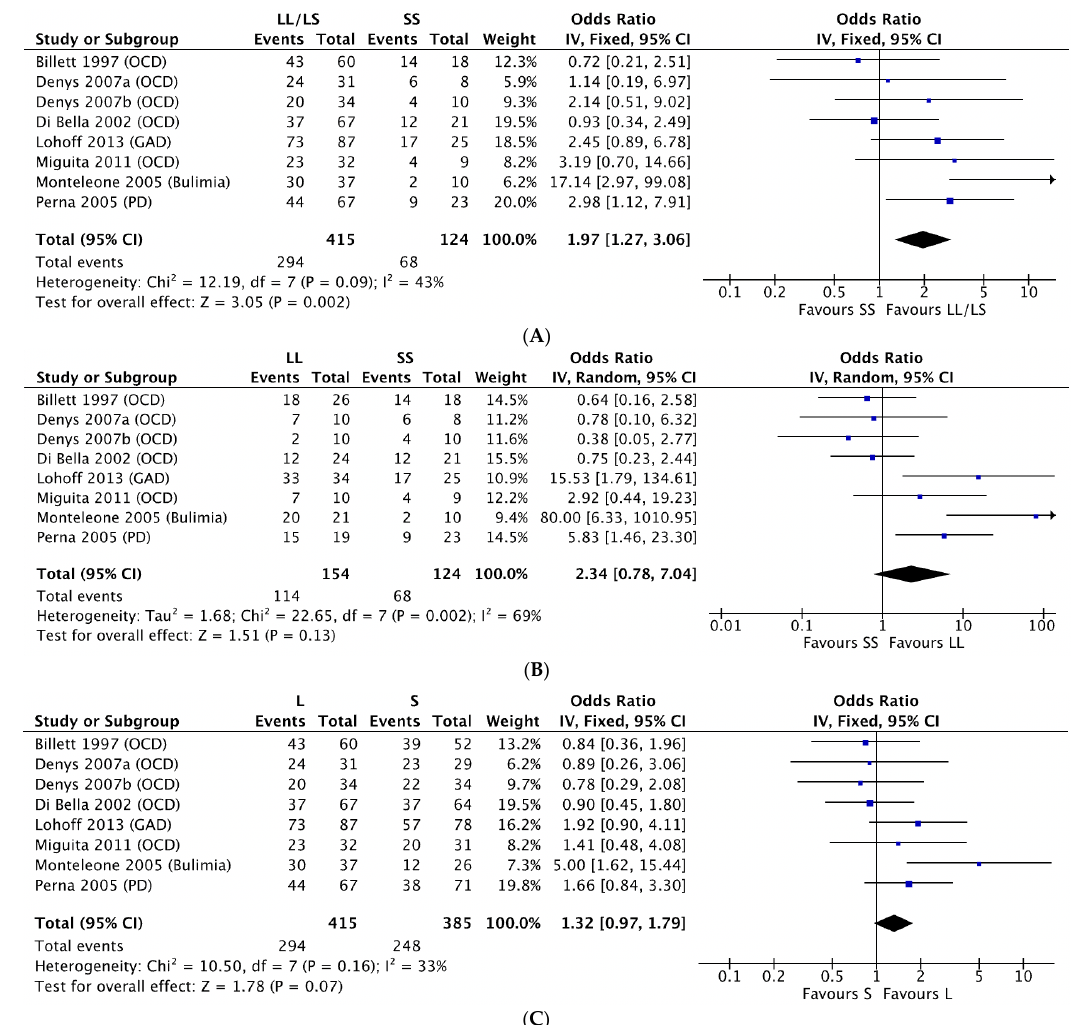
Figure 2. Forest plots of 5-HTTLPR polymorphisms and antidepressant response in all studies by genotype comparisons. ( A ) LL/LS vs. SS; ( B ) LL vs. SS; ( C ) L vs. S. GAD, generalized anxiety disorder; OCD, obsessive compulsive disorder; PD, panic disorder.